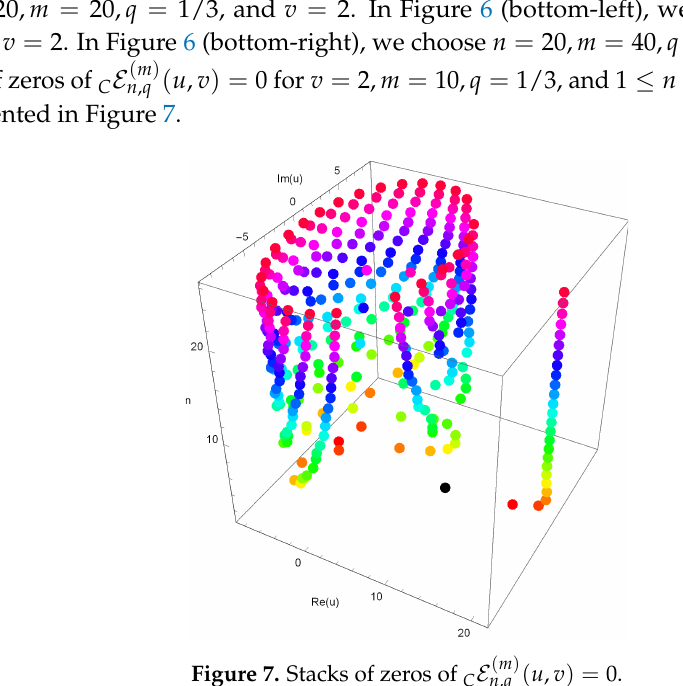
Figure 7. Stacks of zeros of C E